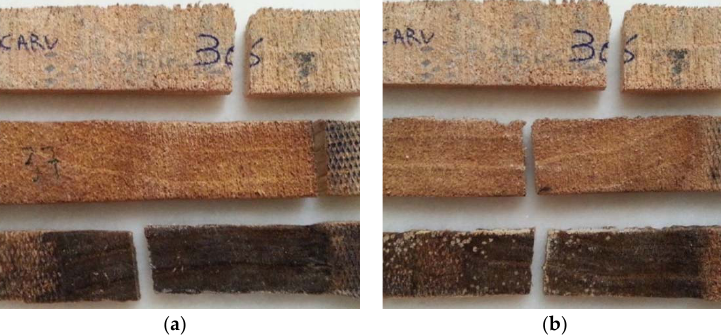
Figure 15. Oak samples submitted to the tensile test after three weeks ( a ) and three months ( b ). The sample immersed in 5% NaClO for three weeks has broken near the clamping zone of the claws of the testing machine, a form of rupture by pure tensile stress. Thus, there is a significant difference of the cross-section near the rupture zone. By contrast, the standard sample ruptured near the central zone, as did the 100% NaClO one and also every specimen after three months, which demonstrates that they present a uniform cross-sectional area dimension throughout their length. The samples immersed in 100% NaClO in both cases present a higher moisture content when compared to the other samples, proved by the darker colouration of the material. This fact is due to the high amount of fluid that remains inside the sample, not being naturally released as water. The retained fluid is sodium hypochlorite, since this phenomenon only occurs in samples immersed in concentrations of 100% NaClO.